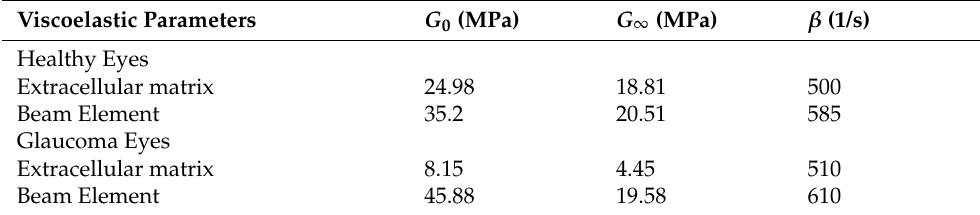
Table 1. Viscoelastic parameters for the healthy and glaucoma TM patch FE models. The ECM and beam elements were modeled as viscoelastic material.